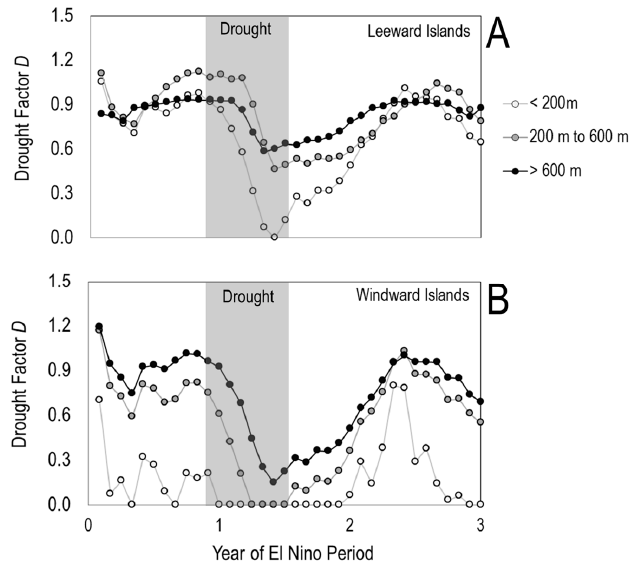
Figure 4. Drought factors D for ( A ) leeward and ( B ) windward islands for the algebraic model. These factors are based on SUTRA numerical modeling simulations and are used to scale the average Z max value provided by the algebraic model.